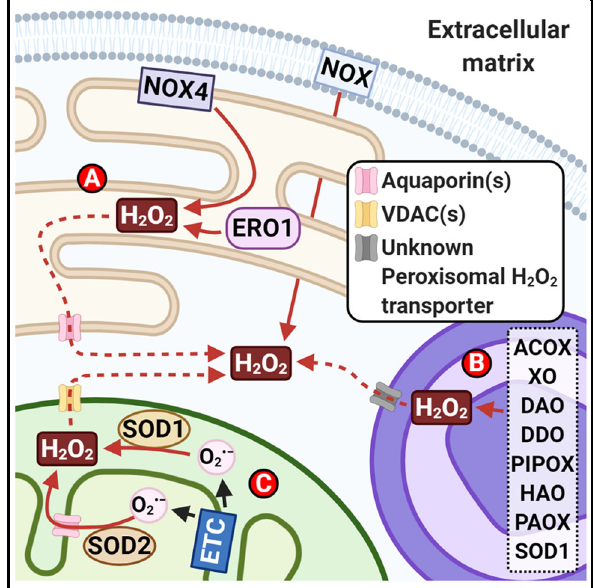
Fig. 1 Major sources of cellular reactive oxygen species (ROS) production. The three main producers of cellular ROS are the mitochondria, the endoplasmic reticulum (ER) and the peroxisomes. A In the ER, the major source of ER-ROS production is from the process of oxidative protein folding for disul fi de bond formation. This process is governed by the enzyme ER oxidoreductin 1 (ERO1). NADPH oxidase 4 (NOX4) is also involved in the production of ER-ROS, mainly ER-H 2 O 2 . B In the peroxisomes, the major producer of peroxisomal ROS is the process of beta-oxidation of fatty acids. The main player involved is the enzyme, Acyl-CoA oxidase (ACOX). Numerous other enzymes in the peroxisomes also contribute to the production of peroxisomal ROS: xanthine oxidase (XO); D -amino-acid oxidase (DAO); D -aspartate oxidase (DDO); L -pipecolic acid oxidase (PIPOX); L - α -hydroxyacid oxidase (HAO); polyamine oxidase (PAOX). C The main producers of mitochondrial ROS in the mitochondria are from the activity of the electron transport chain (ETC) during oxidative phosphorylation (OXPHOS). The mitochondrial superoxide (O 2 (cid:129) − ) produced by the ETC is immediately converted to mitochondrial hydrogen peroxide (H 2 O 2 ) by superoxide dismutase 1 and 2 (SOD1 and SOD2). In general, cellular H 2 O 2 is one of the major and common forms of cellular ROS. Its role as a secondary messenger and its production in these three organelles has raised a suggestion of a potential redox signaling complex among them, highlighting the importance of cellular H 2 O 2 in cellular redox communications. Created with